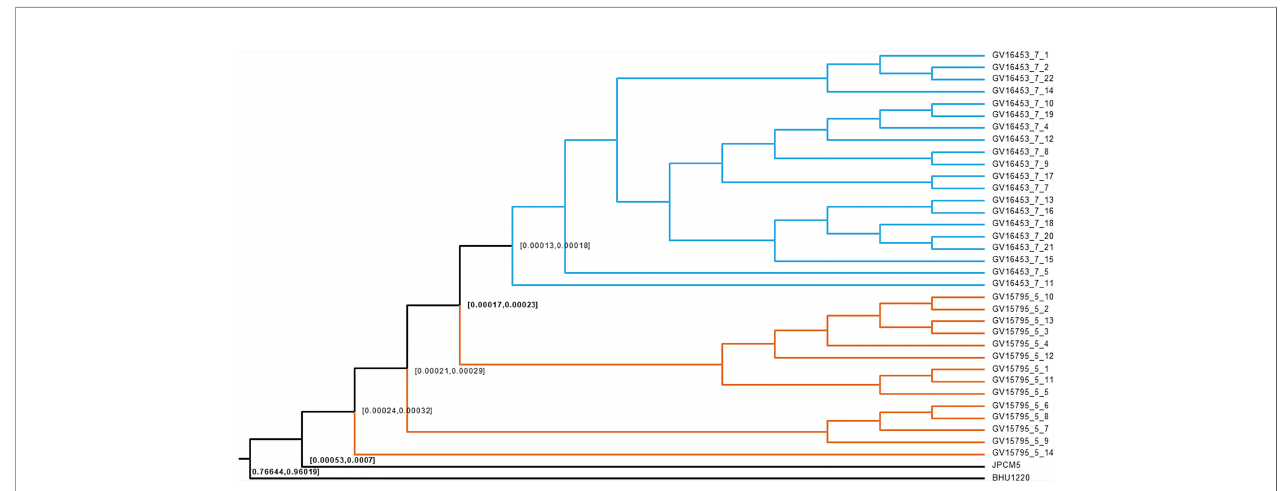
FIGURE 4 | Bayesian dating of L. (L.) infantum isolates. The fi gure shows a cladogram corresponding to the strict clock model. Nodes are located at the mean divergence and numbers represent 95% con fi dence intervals. The result shows an earlier divergence of both L. (L.) infantum sub-populations in Governador Valadares. JPCM5: L. (L.) infantum JPCM5, BHU1220: Leishmania (L.) donovani BHU1220 strain. Colors in the branches distinguish the 2015 (Blue) and 2008/2012 (Orange)